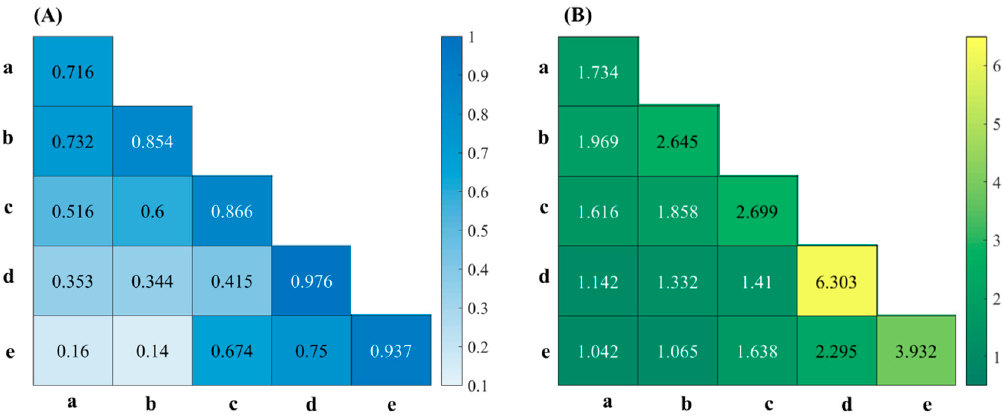
Figure 8. The Rp 2 ( A ) and RPD ( B ) of PLS model with different soil particle sizes: (a) 1–2 mm; (b) 0.45–1 mm; (c) 0.28–0.45 mm; (d) 0.18–0.28 mm; (e) 0–0.18 mm.